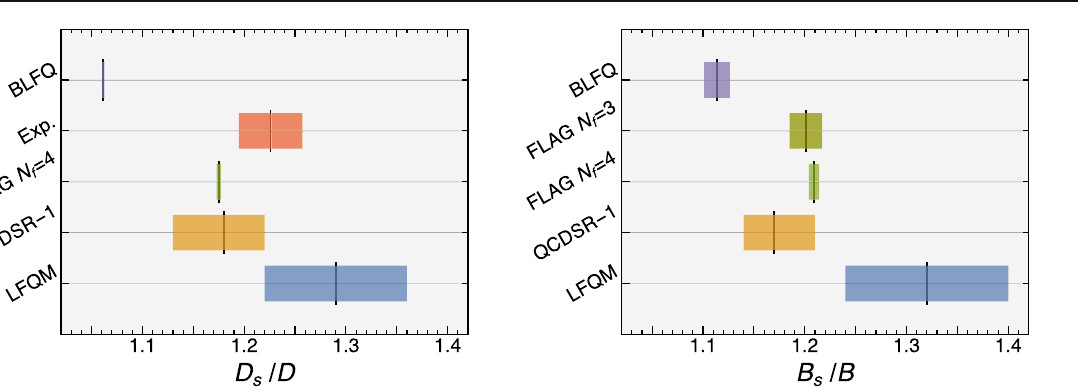
Fig. 6 Comparisonoftheratios R ( f D approaches [35,47,56] and experimental average [20]. See Table 2 for thespecificvaluesandtheirsourcesforeachresultplottedhere.Thever-